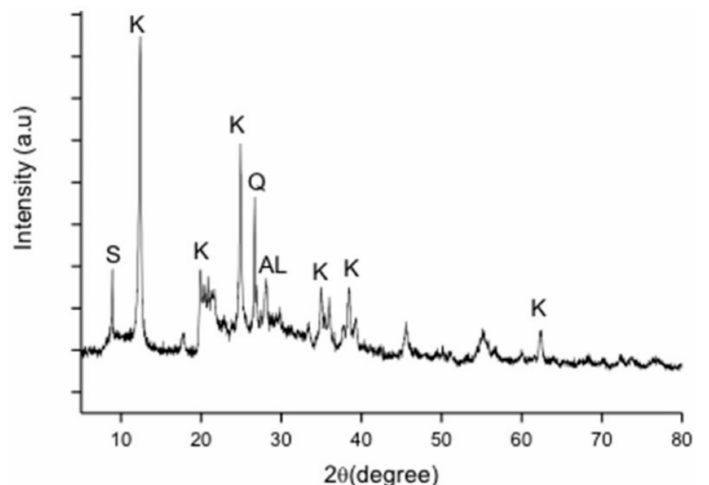
Figure 4. Phase composition of kaolin–GGBS geopolymer after curing for 14 days. (S: Silicon Oxide, K: Kaolinite, Q: Quartz, AL: